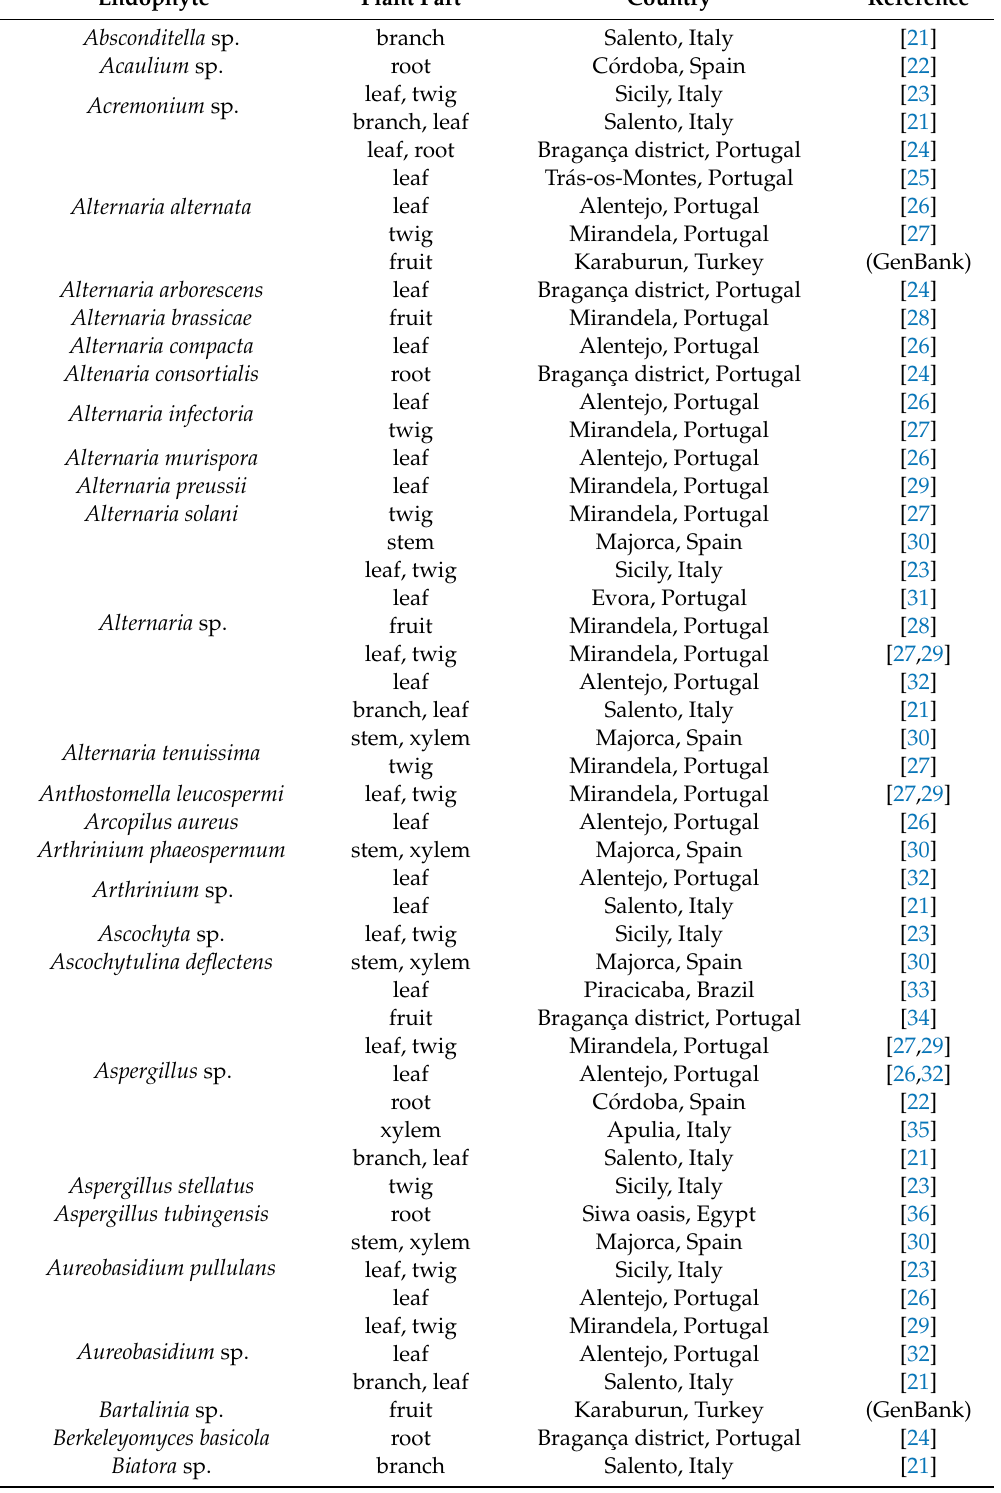
Table 1. Endophytic Ascomycota reported from Olea europaea